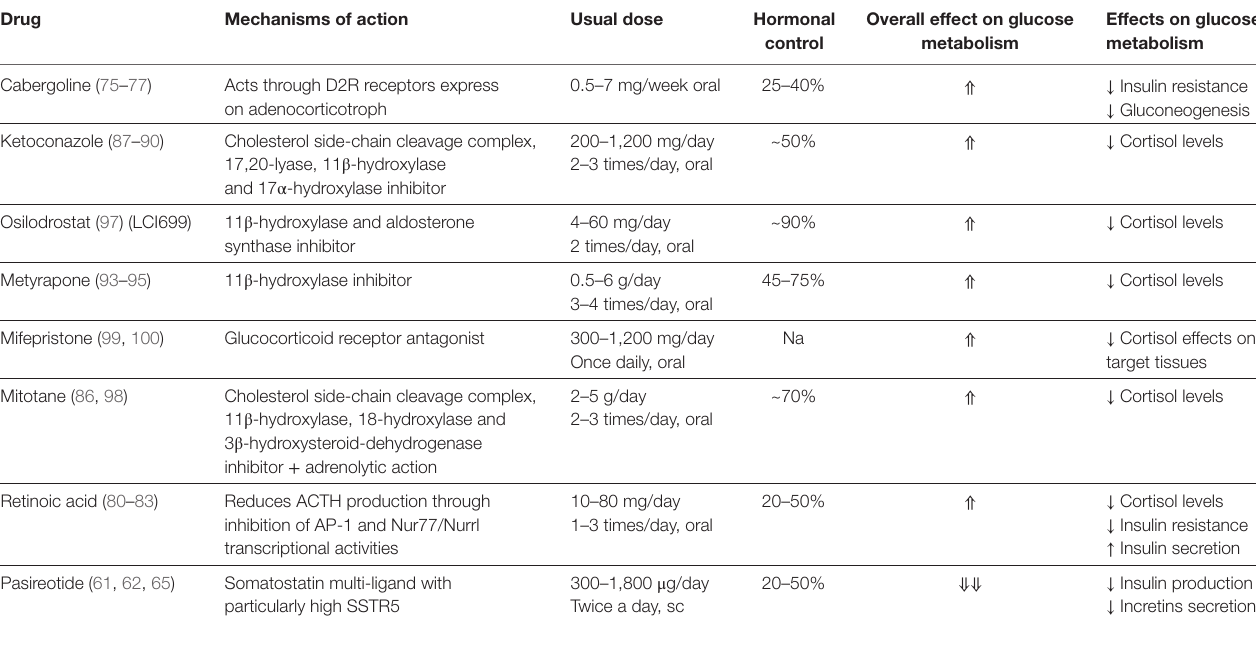
TABLe 1 | Medications available to treat Cushing’s disease and their effects on glucose metabolism.